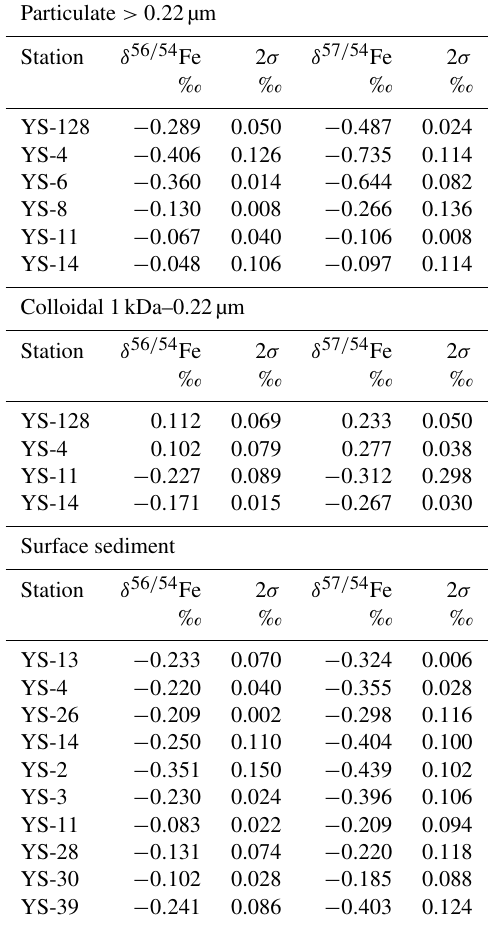
Table 4. Fe-isotope data for the particulate and the colloidal phase as well as Fe-isotope data for the surface